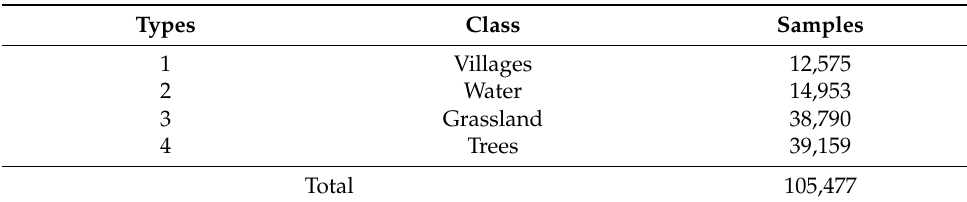
Figure 6. The HRSI after Jiuzhaigou M7.0 earthquake. Table 4. The number of samples and four types.